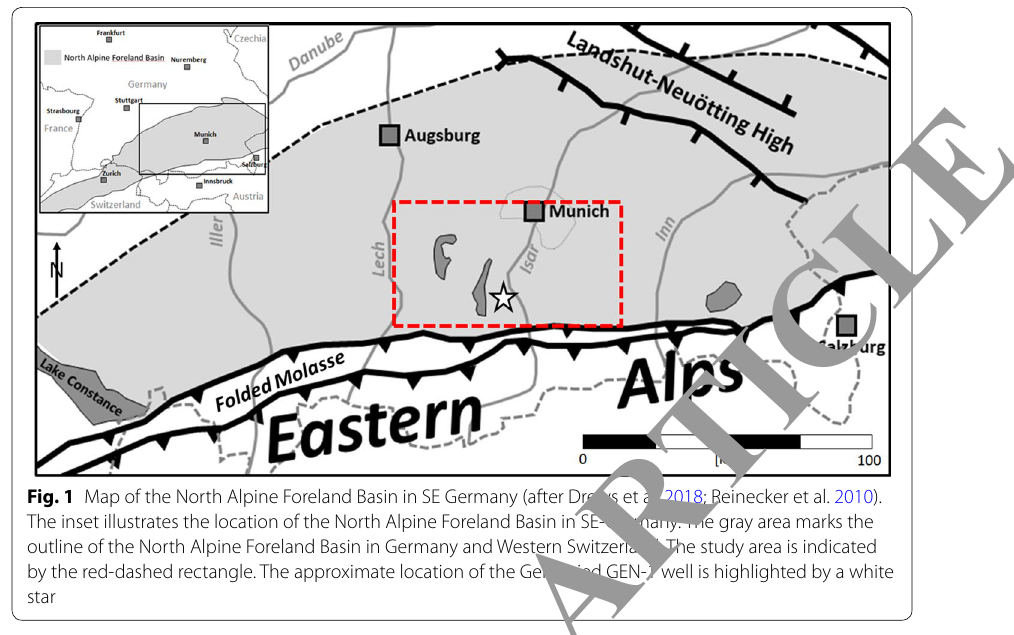
Fig. 1 Map of the North Alpine Foreland Basin in SE Germany (after Drews et al. 2018; Reinecker et al. 2010). The inset illustrates the location of the North Alpine Foreland Basin in SE-Germany. The gray area marks the outline of the North Alpine Foreland Basin in Germany and Western Switzerland. The study area is indicated by the red-dashed rectangle. The approximate location of the Geretsried GEN-1 well is highlighted by a white star